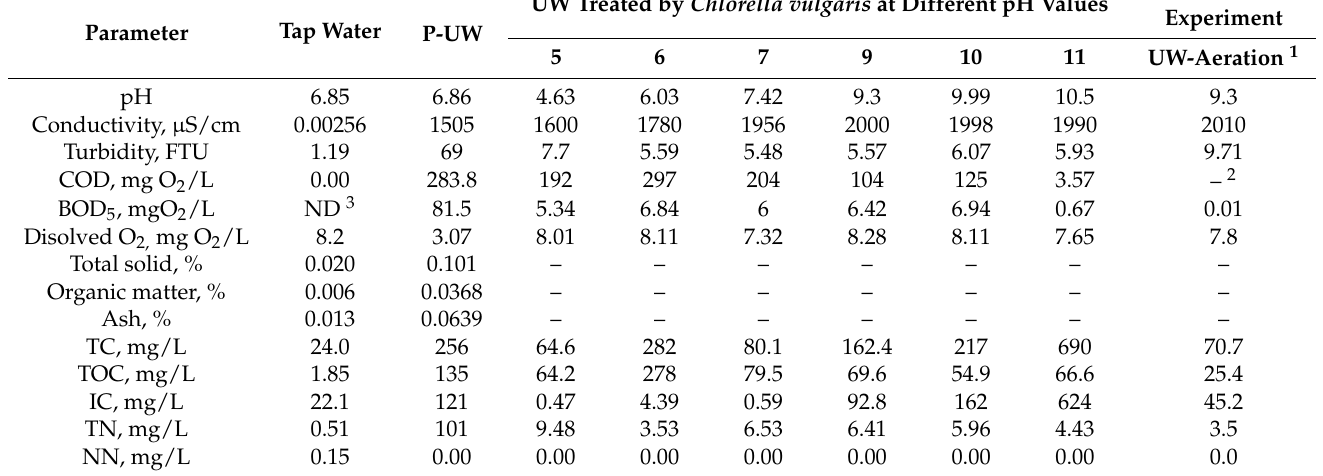
Table 1. Characterization of primary urban wastewater (P-UW) before and after treatment by Chlorella vulgaris at different pH values and control cultures.